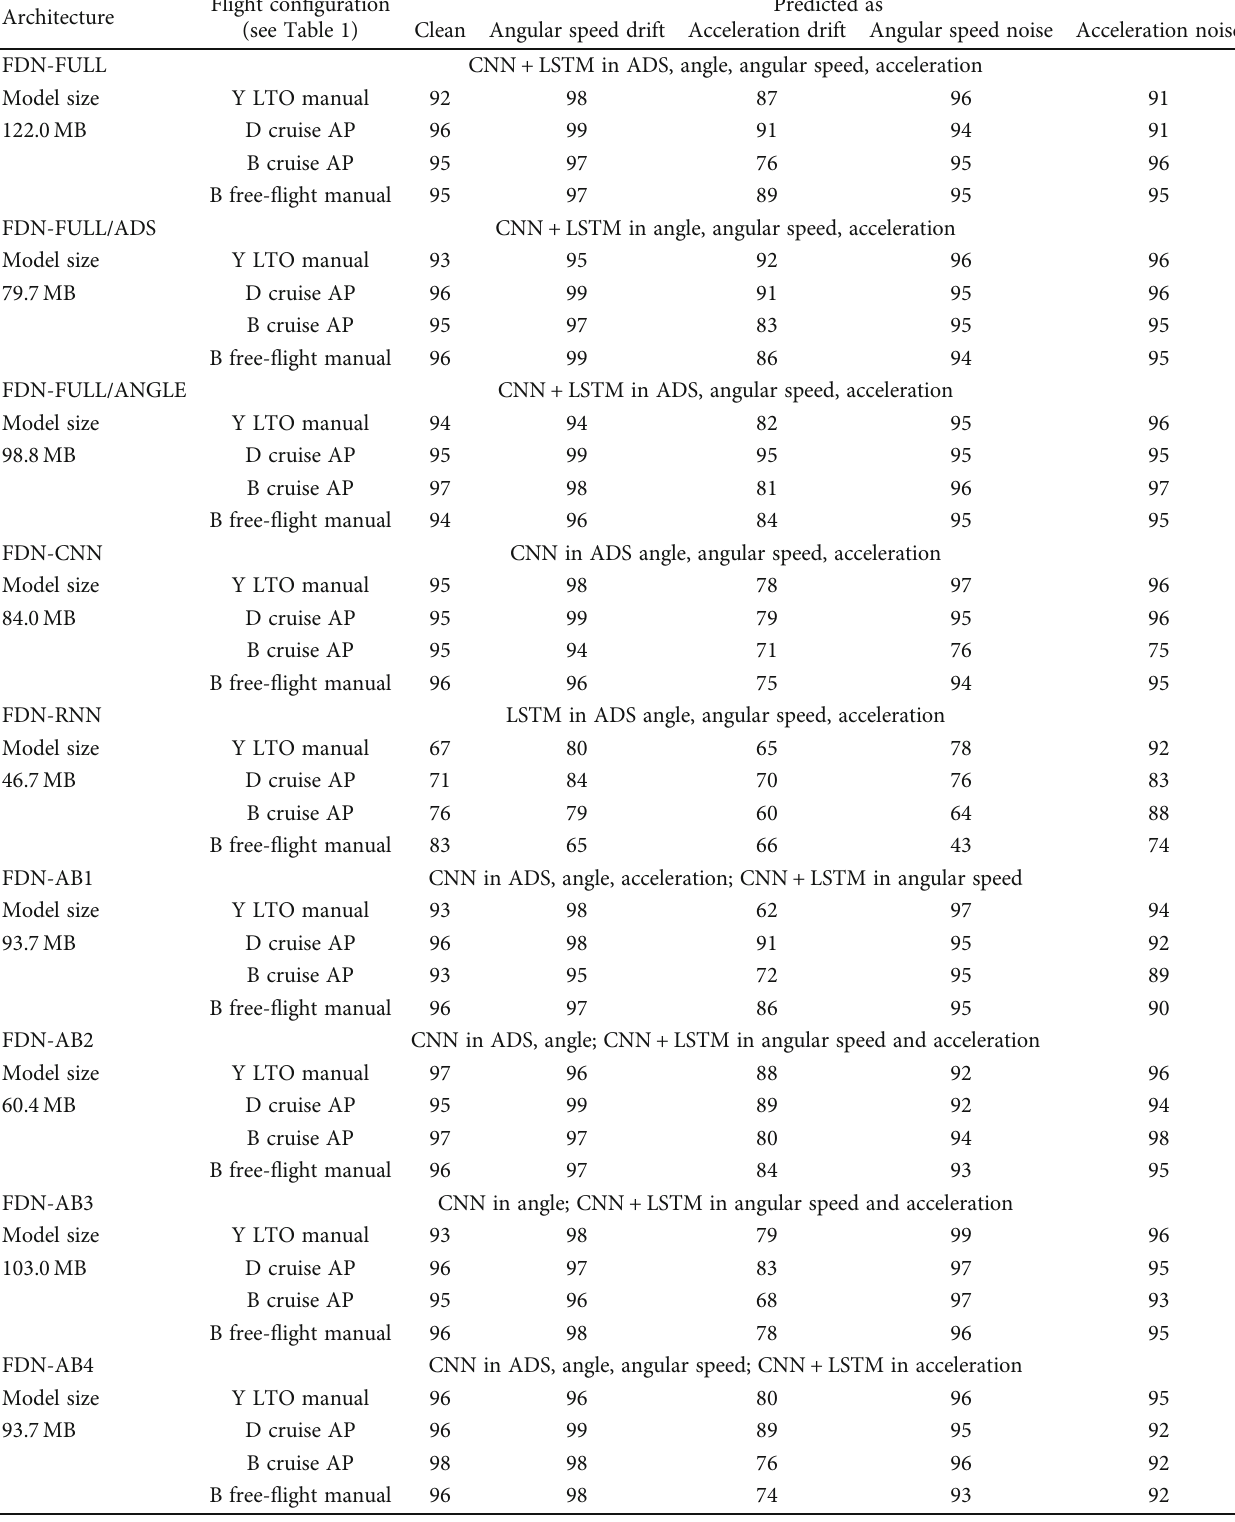
Table 5: Prediction performance of di ff erent FDN